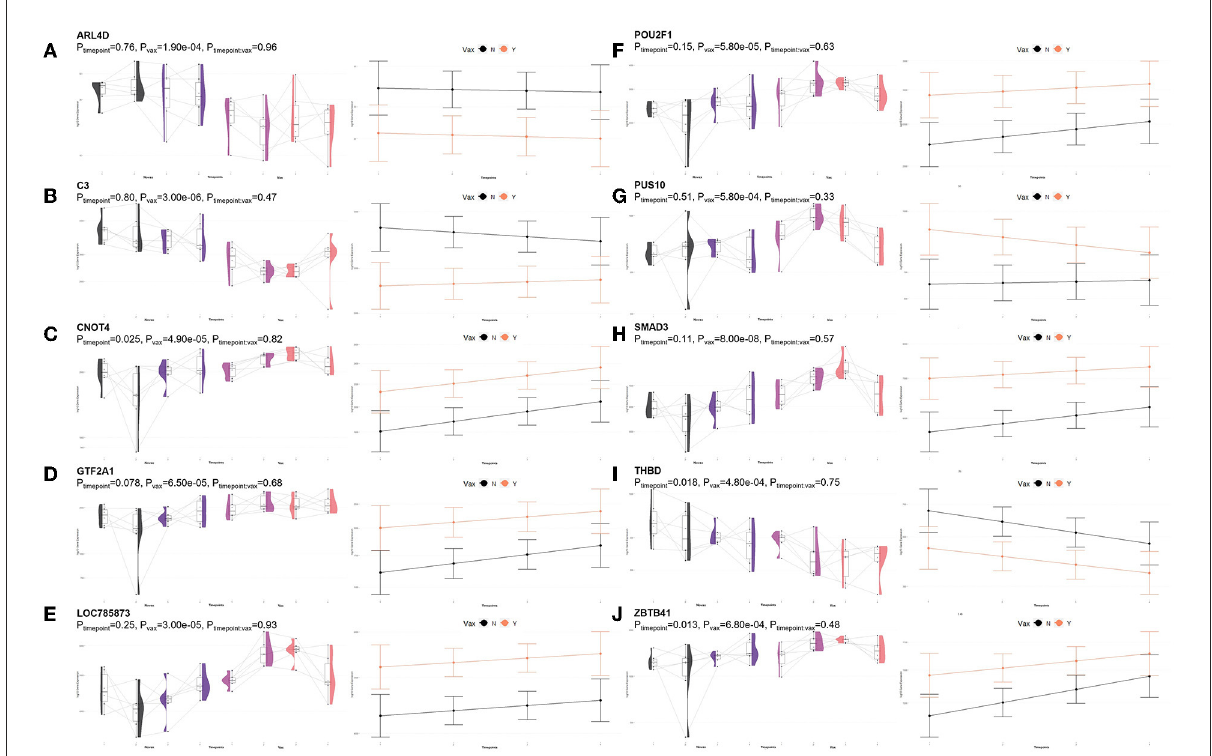
FIGURE7 Gene pairplots and modeled expression trends of key DEGs found in timepoint analyses. Pairplots (left side) demonstrate the log10 normalized gene expression of each sample across all timepoints, overlapped with a violin plot (depicting numerical distributions by density). Box-and-whisker plots represent median expression values (black line), the first (lower) and third quartiles (boxplot limits), 1.5 times the interquartile ranges (whiskers), and outlier expression levels for each timepoint (points outside whiskers). Modeled expression trends (right side) depict the overall differences between groups over each timepoint. Points represent the mean log10 normalized expression value for each group within a timepoint, and bars represent the standard error of log10 normalized expression for each group; orange represents the vaccinated group and black represents the non-vaccinated group. These plots depict the relative expression and glmmSeq level of significance for (A) ARL4D , (B) C3 , (C) CNOT4 , (D) GTF2A1 , (E) LOC785873 (TRIM26), (F) POU2F1 , (G) PUS10 , (H) SMAD3 , (I) THBD , and (J) ZBTB41 .